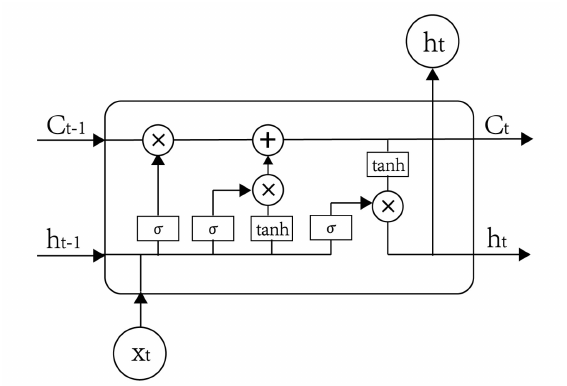
Figure 2. Structure of a cell of an LSTM NN (source: Qiu et al. (2020), p.